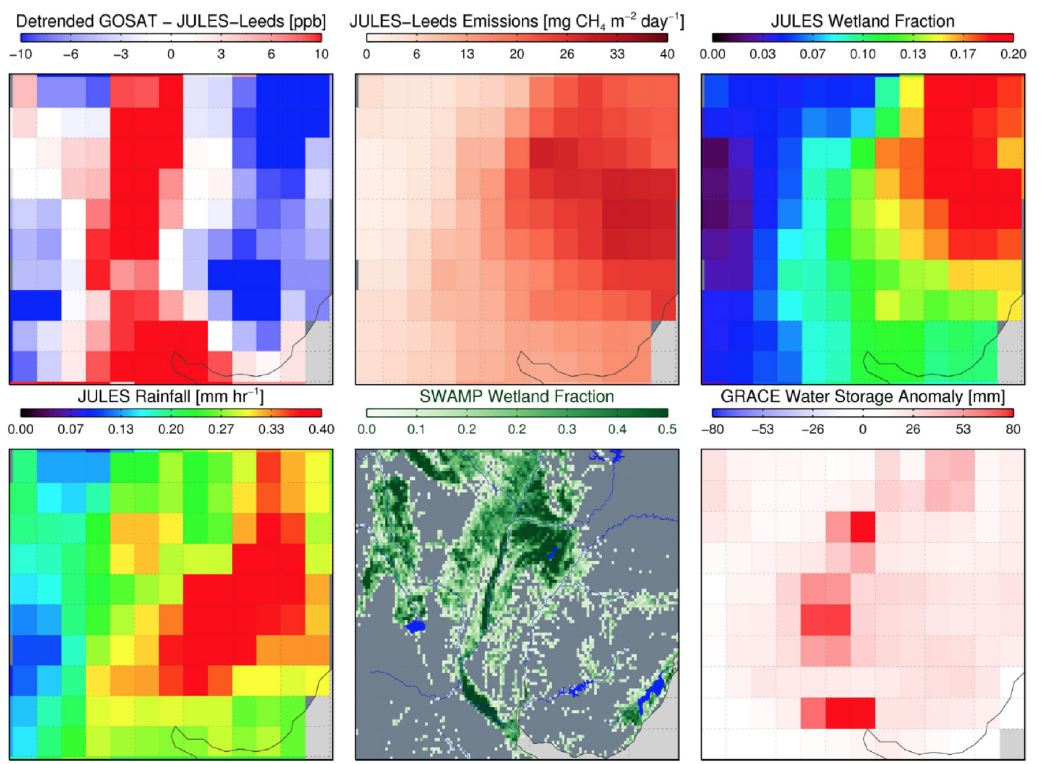
Figure 14. Maps of the Paraná region for November 2009 to February 2010 showing ( top – left , clockwise): GOSAT-JULES difference, JULES wetland emissions, JULES wetland fraction, GRACE water storage anomaly, Sustainable Wetland Adaptation and Mitigation Program (SWAMP) wetland fraction and JULES rainfall amount